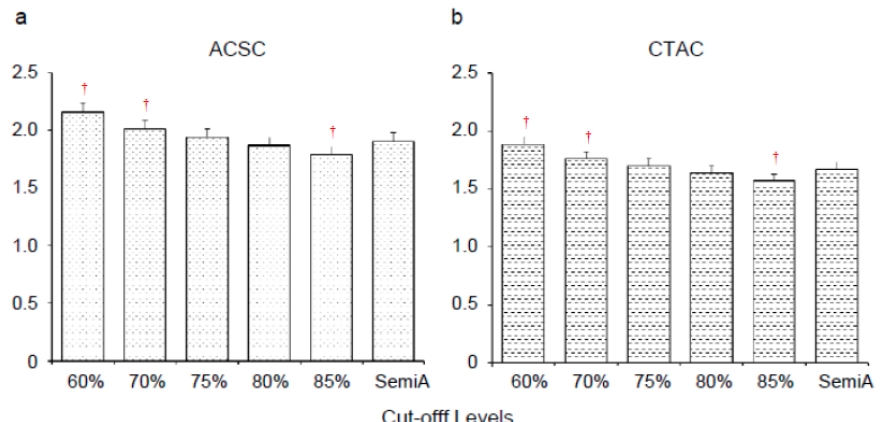
Figure 2. Specific binding ratio (SBR) values (mean ± standard error (SE)) obtained from our previous data of 200 patients with various VOI ref thresholds. Single-photon emission computed tomography (SPECT) images were reconstructed by two methods of attenuation correction with and without scatter correction (ACSC ( a ) and CTAC ( b )). Cut-off levels of 75% and 80% of the maximum VOI ref count showed no significant difference from the results calculated using the semi-automatic method (semi-A). † p < 0.0001.